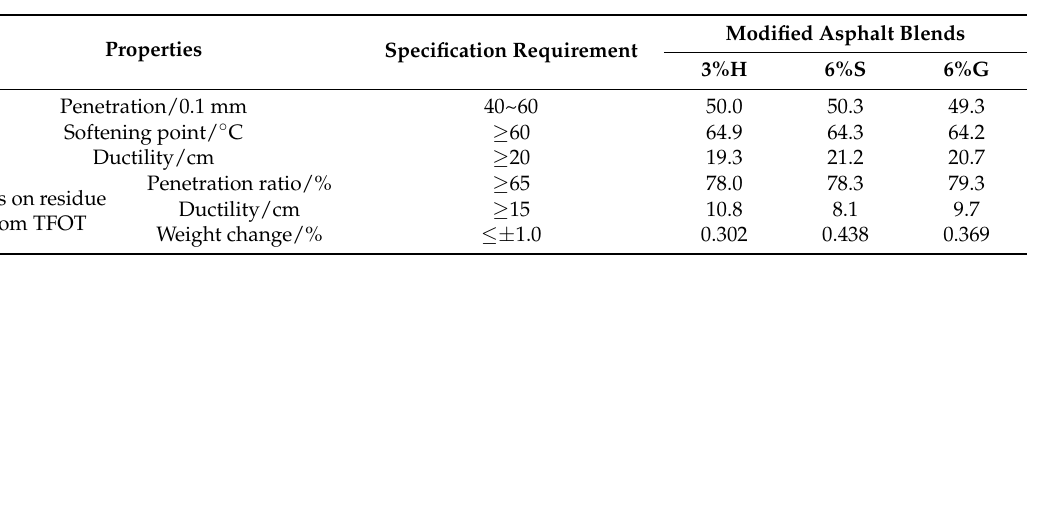
Table 7. Anti-aging property of modified asphalt